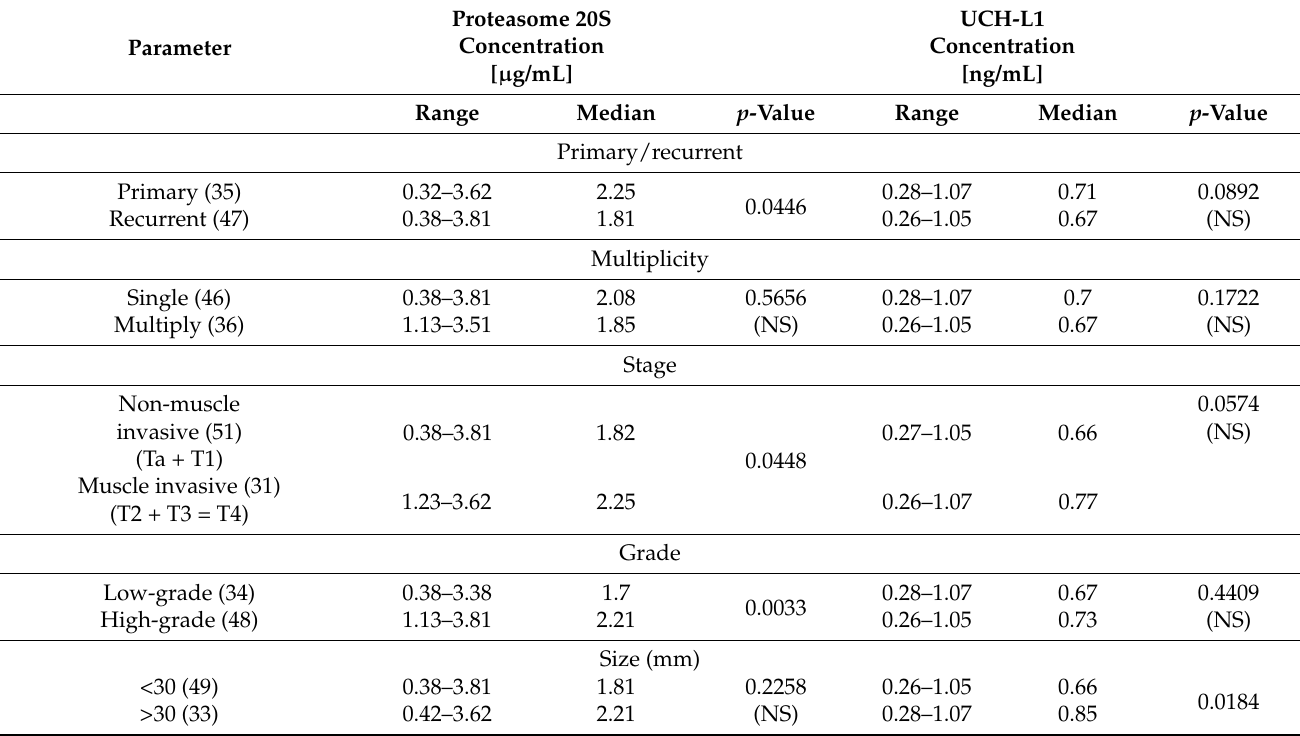
Table 4. Diagnostic characteristics of urine 20S proteasome and UCH-L1 concentration ratio compared with various clinicopathological